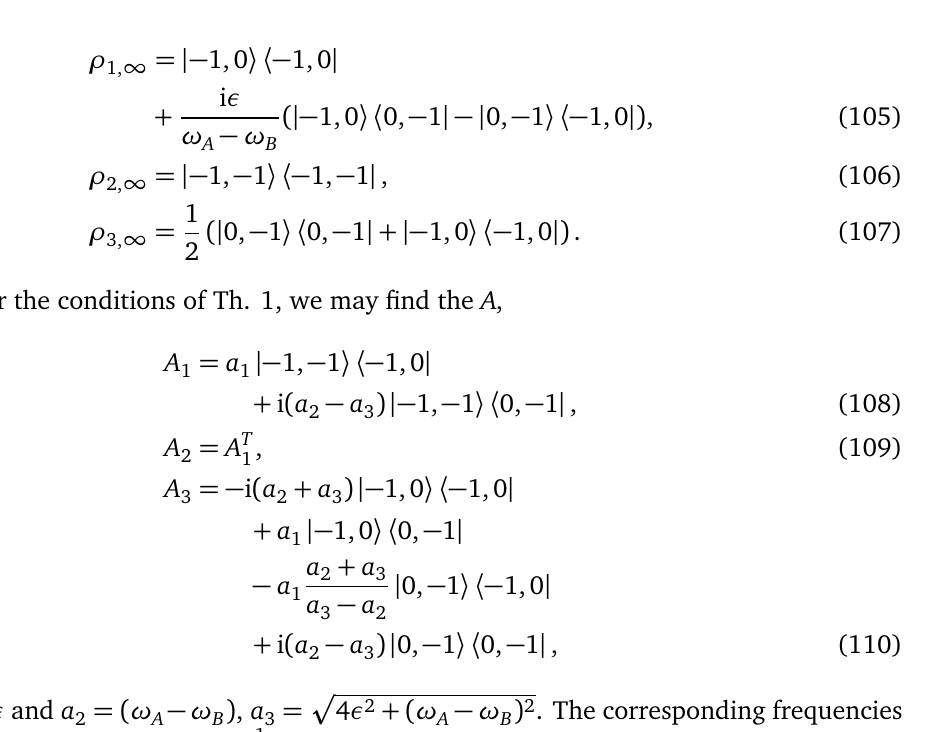
Figure 7: Metastable anti-synchonisation of the inverted limit cycle model in the Quantum Zeno limit for γ = 100, µ = 0, ω the system is initialised in ρ ( 0 ) = | 0 〉 unitary dynamics lifting the degeneracy in the stationary subspace of the dissipation. Comparison with Fig. 6 shows that in the Zeno limit the oscillations are now on timescales relevant to the